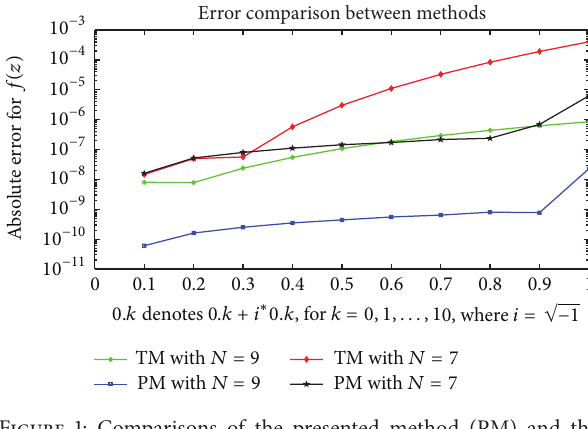
Figure 1: Comparisons of the presented method (PM) and the Taylor method (TM) of Example 13.